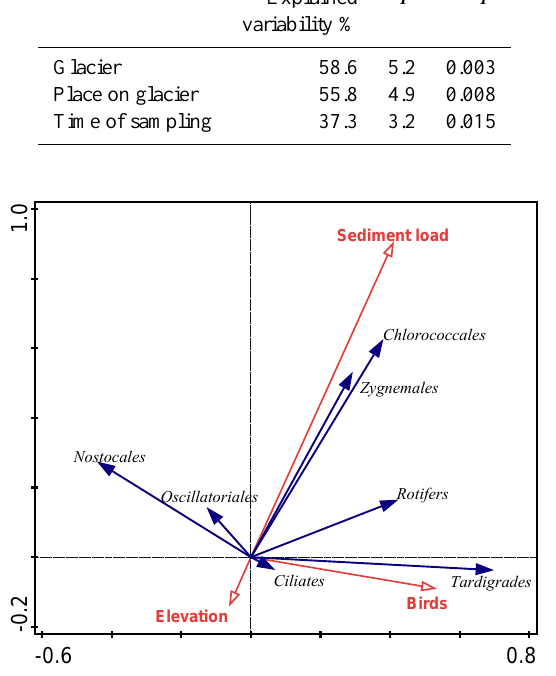
Figure 5. Biplot for the partial RDA with glacier and place as covariables, after interactive forward-selection covariates analysis. Rotifers in this figure do not include Encentrum sp. due to their low abundances.